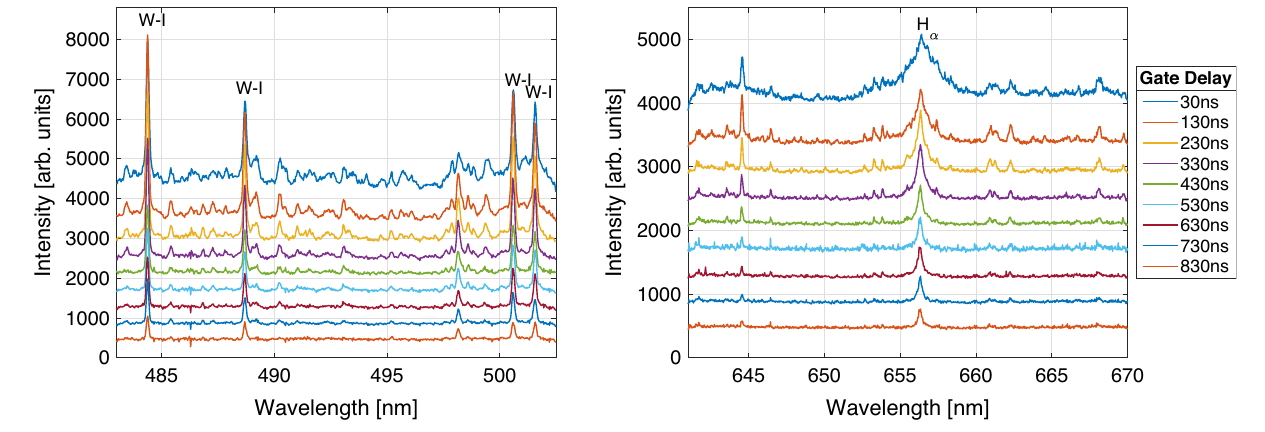
Figure 2. Time resolved emission from the tungsten sample under fs laser irradiation in argon. The gate width is set to 100 ns and the laser fluence is determined as 31J / cm 2 . For visibility 400 counts are added across two distinct spectral ranges for each given gate delay.